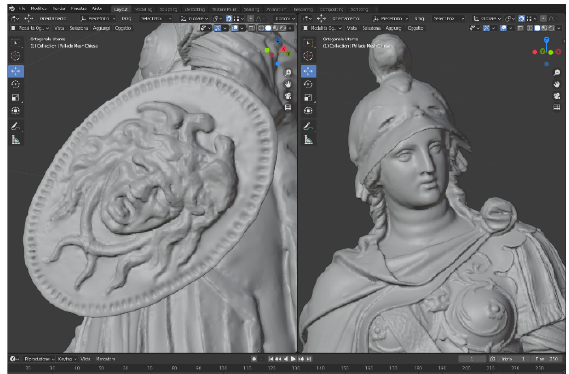
Figure 19. Mesh of Pallas in the Blender software.